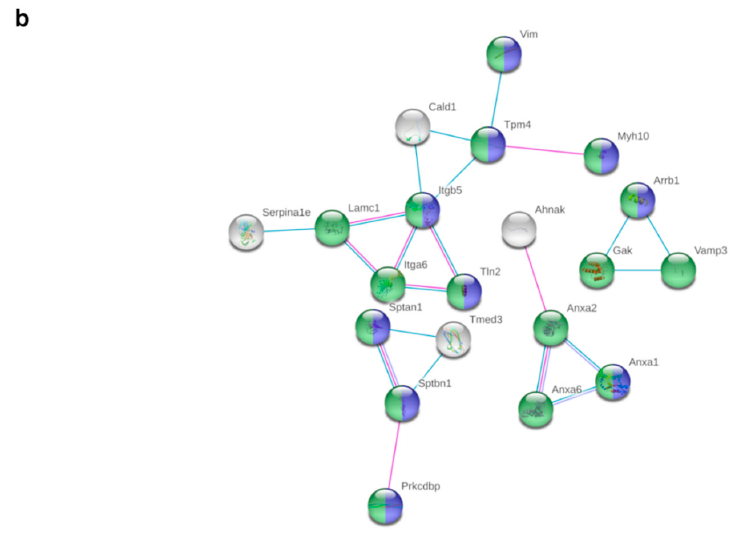
Figure 3. Potential interactions, indicated by lines between two proteins (blue: based on curated databases, pink: experimentally determined, purple: protein homology), were determined by STRING-analysis between significantly (fold change > 1.5, q-value < 0.05) and relevantly (full or 0 valid values per group) altered proteins in pgWAT proteome. Non-interacting proteins are hidden. ( a ) shows downregulated proteins and ( b ) shows upregulated proteins by HFD feeding compared to SD. Some functional enrichments of upregulated proteins are highlighted in colour: green: cellular component organisation, blue: cytoskeleton organisation. SD: standard diet; HFD: high-fat diet; pgWAT: perigonadal white adipose tissue.